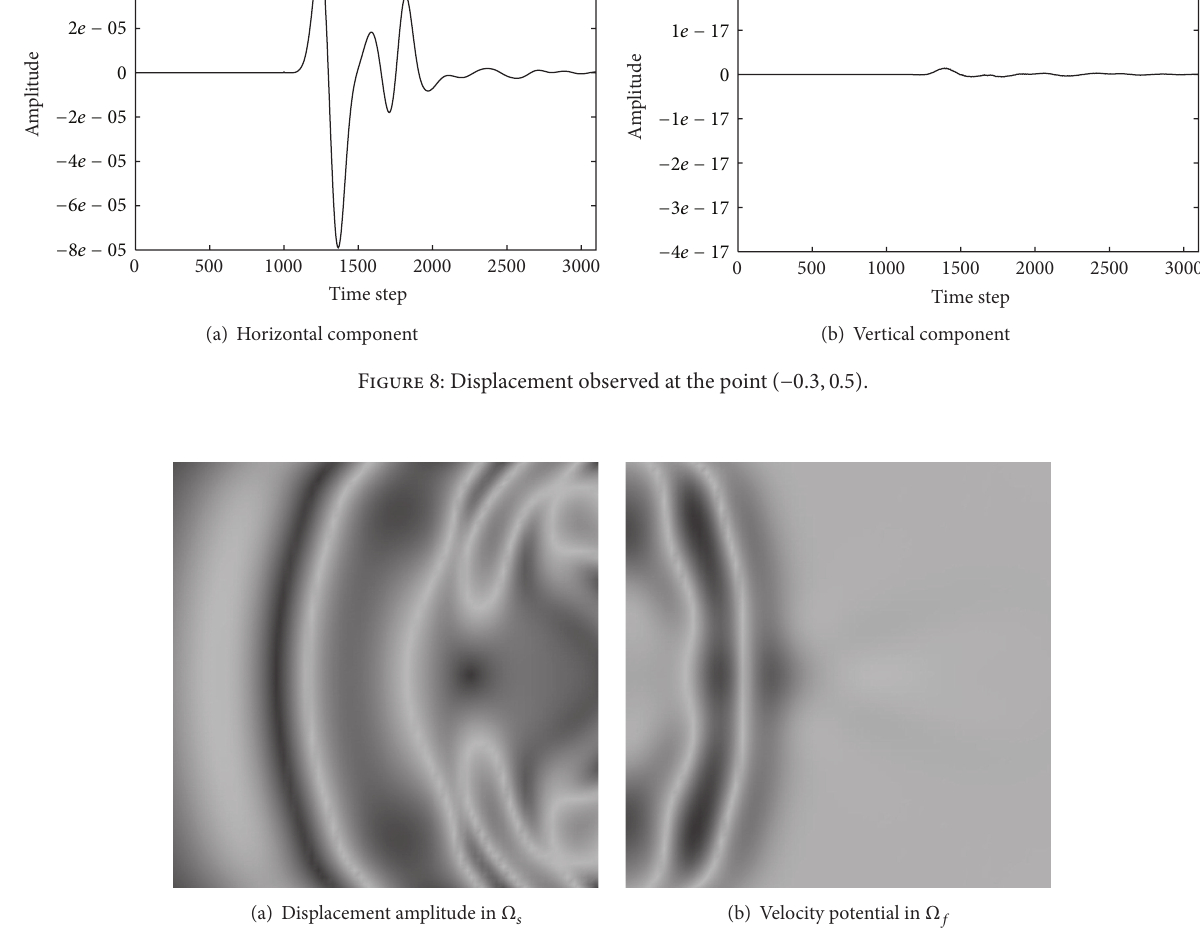
Figure 9: The snapshot of the wave propagation at time step